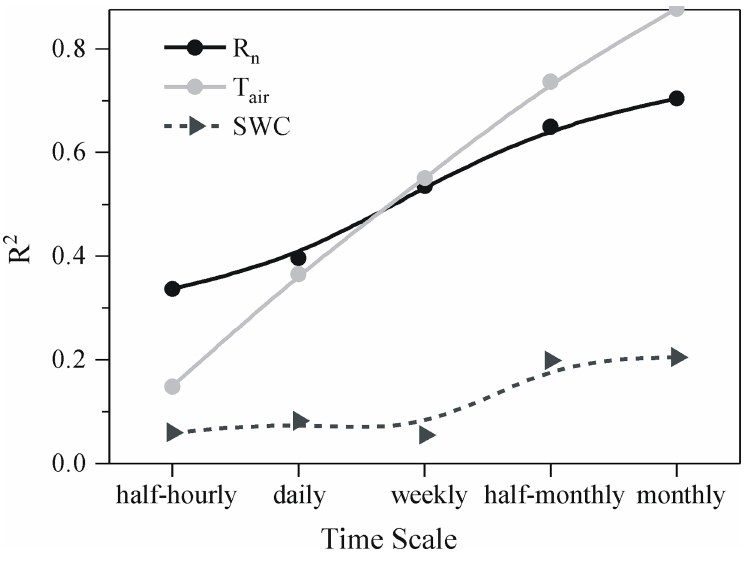
Fig 8. Comparisons of correlations of GPP (gross primary production) to R n (net solar radiation), T air (air temperature) and SWC (soil water content) at various time scales.